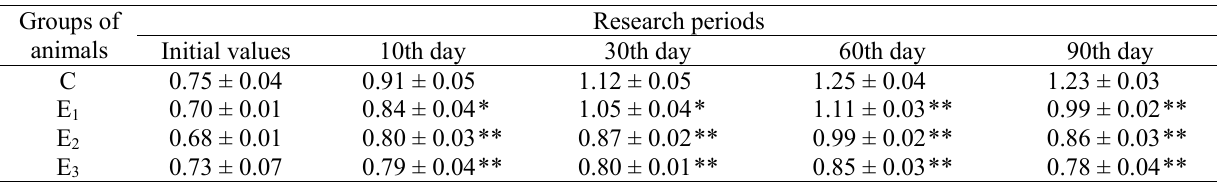
The effect of methionine, phenarone and methyphene on the content of lipid hydroperoxides in the serum of piglets in chronic nitrate-nitrite toxicosis, SU/ml (М±m, n = 5) Groups of